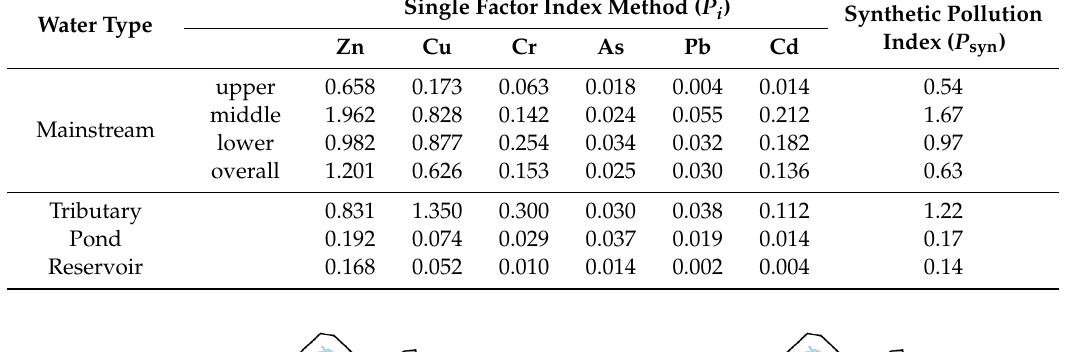
Table 2. Pollution indices of dissolved metal(loid)s in four types of water in Maozhou River watershed. Water Type